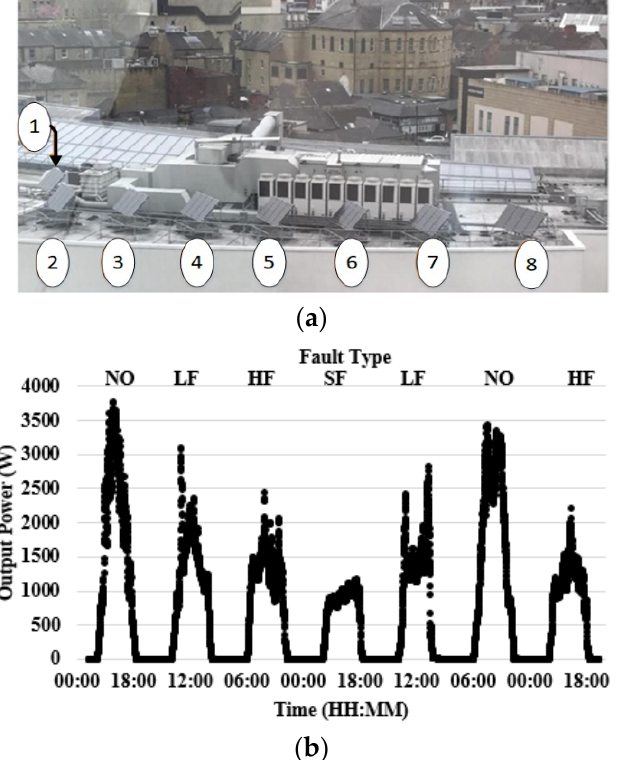
Figure 7. ( a ) Image of the second examined PV system; ( b ) output power measured over one week.